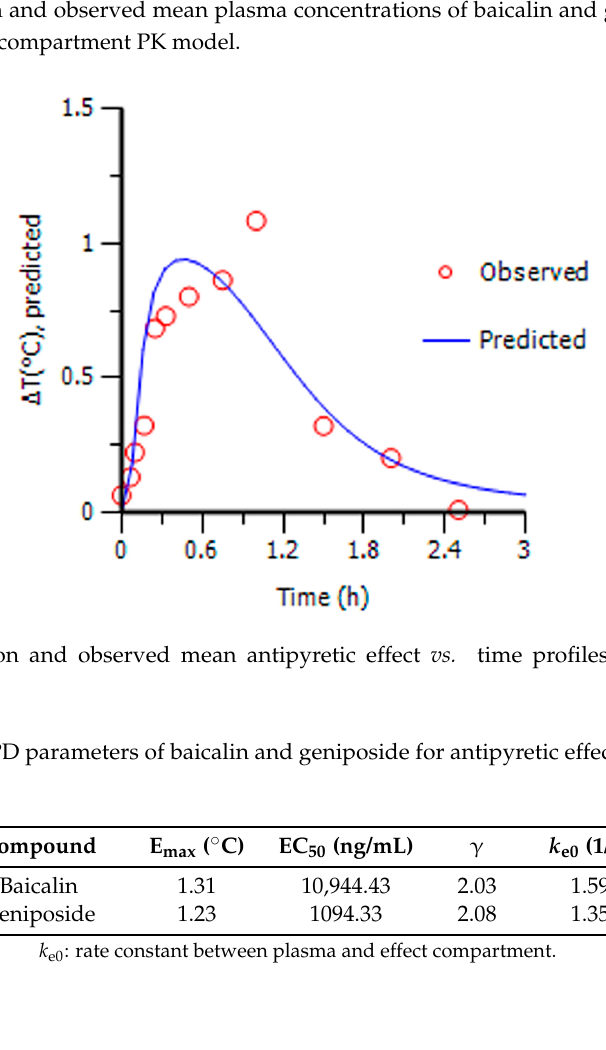
Figure 5. Prediction and observed mean plasma concentrations of baicalin and geniposide vs . time